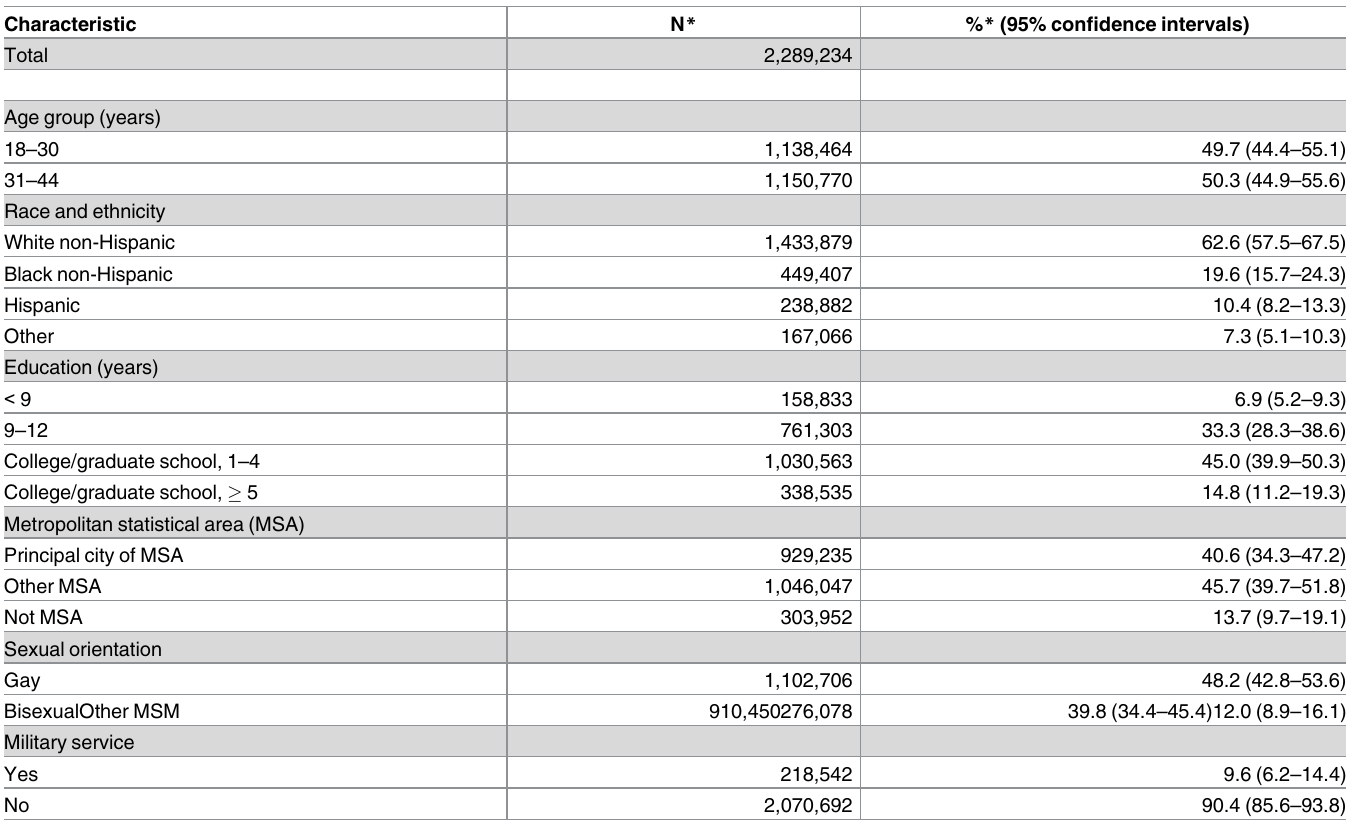
Table 1. Characteristics of men aged 18–44 yearswho self-reported as gay, bisexual, or other men who have sex with men (MSM) in the United States, National Survey of Family Growth 2002, 2006–2010, and